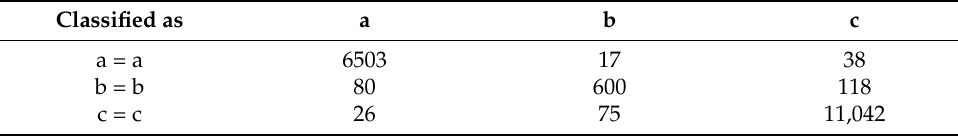
Table A5. The confusion matrix for reliquefication need as outlet